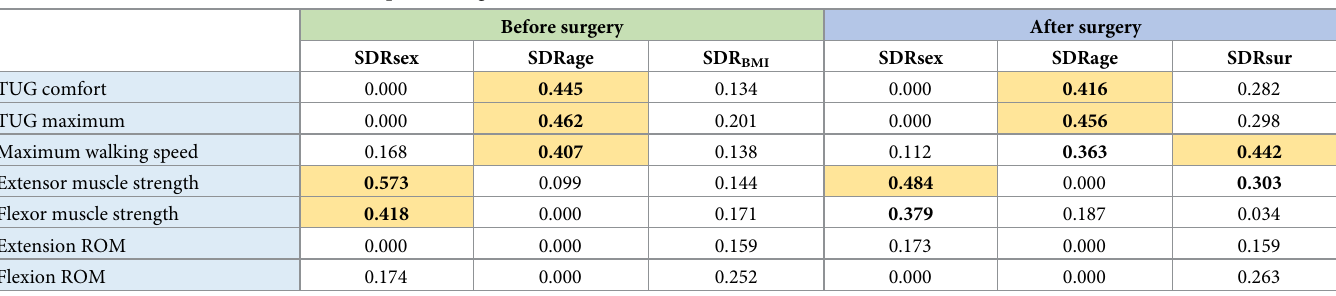
Table 3. SDRs calculated to assess the need for partitioning